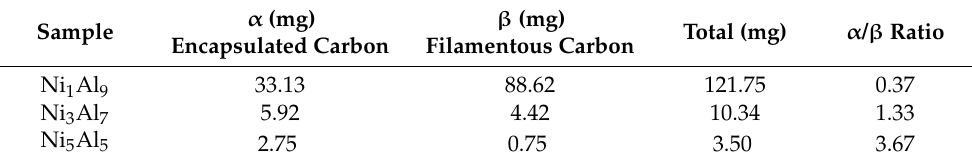
Figure 9. Scanning electron micrographs and temperature-programmed oxidation (TPO) profiles of the spent NiAl 2 O 4 catalysts of various Ni/Al ratios: ( a , d ) Ni 1 Al 9, ( b , e ) Ni 3 Al 7, and ( c , f ) Ni 5 Al 5 . Table 6. Peak allocation and quantification corresponding to the temperature-programmed oxidation (TPO) profile